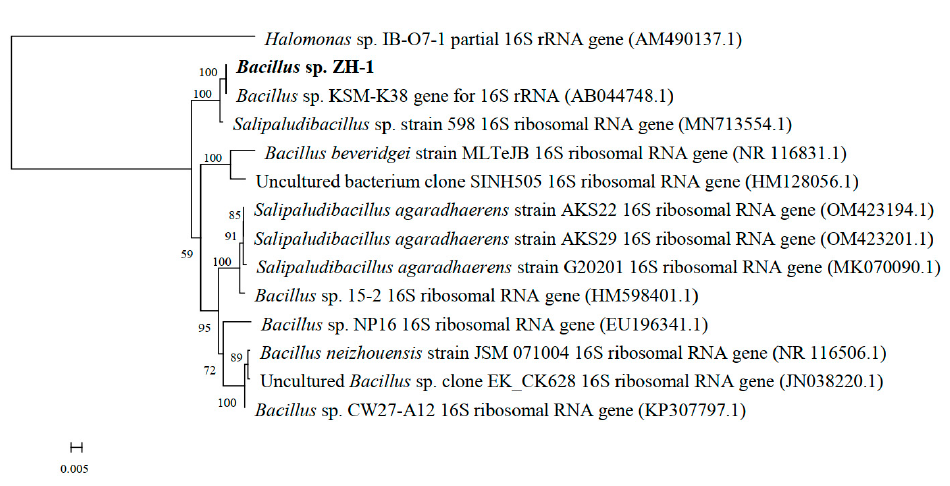
Figure 1. 16S rRNA gene sequence-generated phylogenetic tree showing the relationships of Bacillus sp. ZH-1 and its closest relatives.